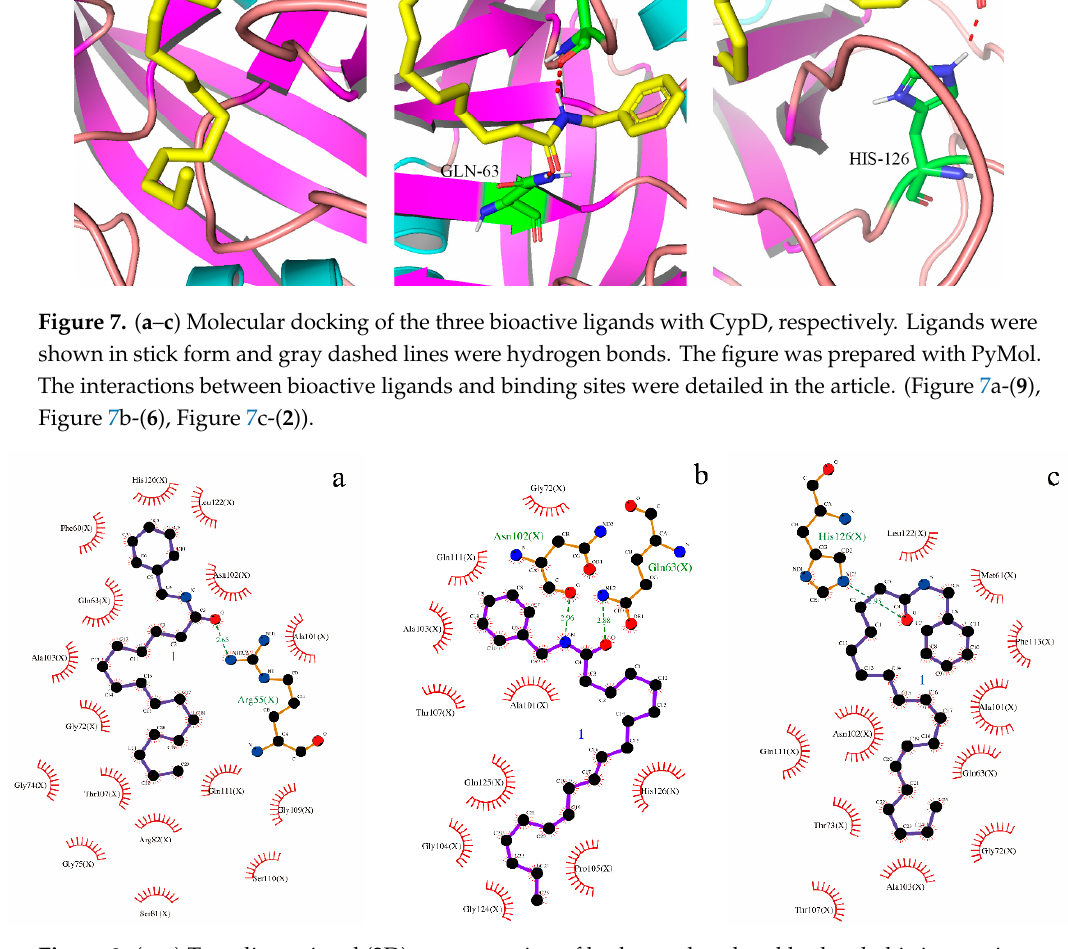
Figure 8. ( a – c ) Two-dimensional (2D) representation of hydrogen bond and hydrophobic interactions. Dashed lines represent hydrogen bonds, and spiked residues form hydrophobic interactions. (Figure 8a-( 9 ), Figure 8b-( 6 ), Figure 8c-( 2 )) .